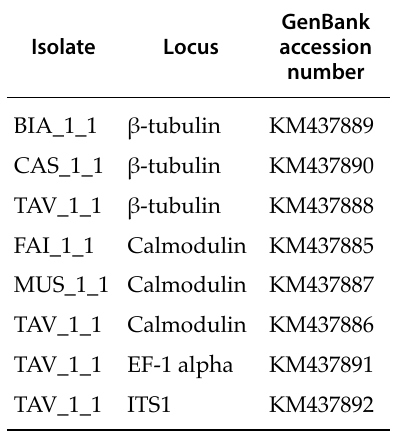
es. At least one sequence for each β-tubulin and calmodu - lin haplotype was